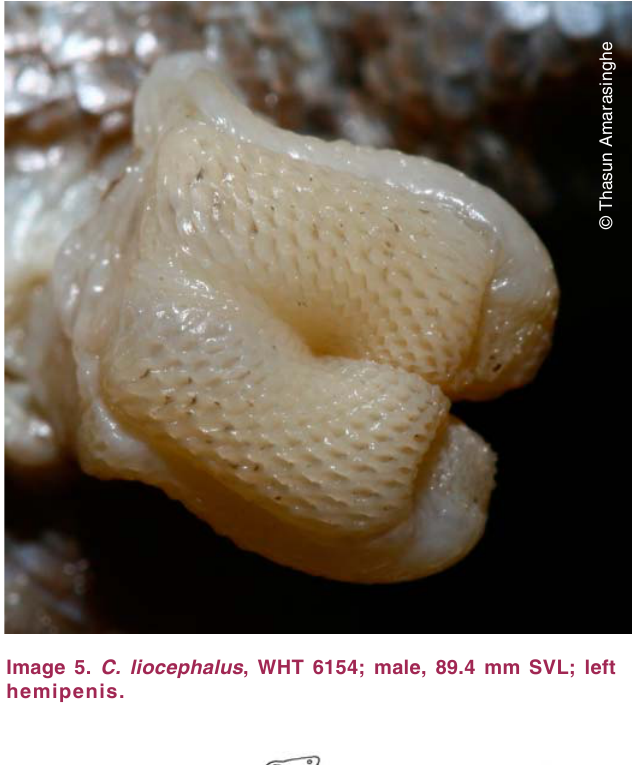
Image 5. C. liocephalus , WHT 6154; male, 89.4 mm SVL; left hemipenis.